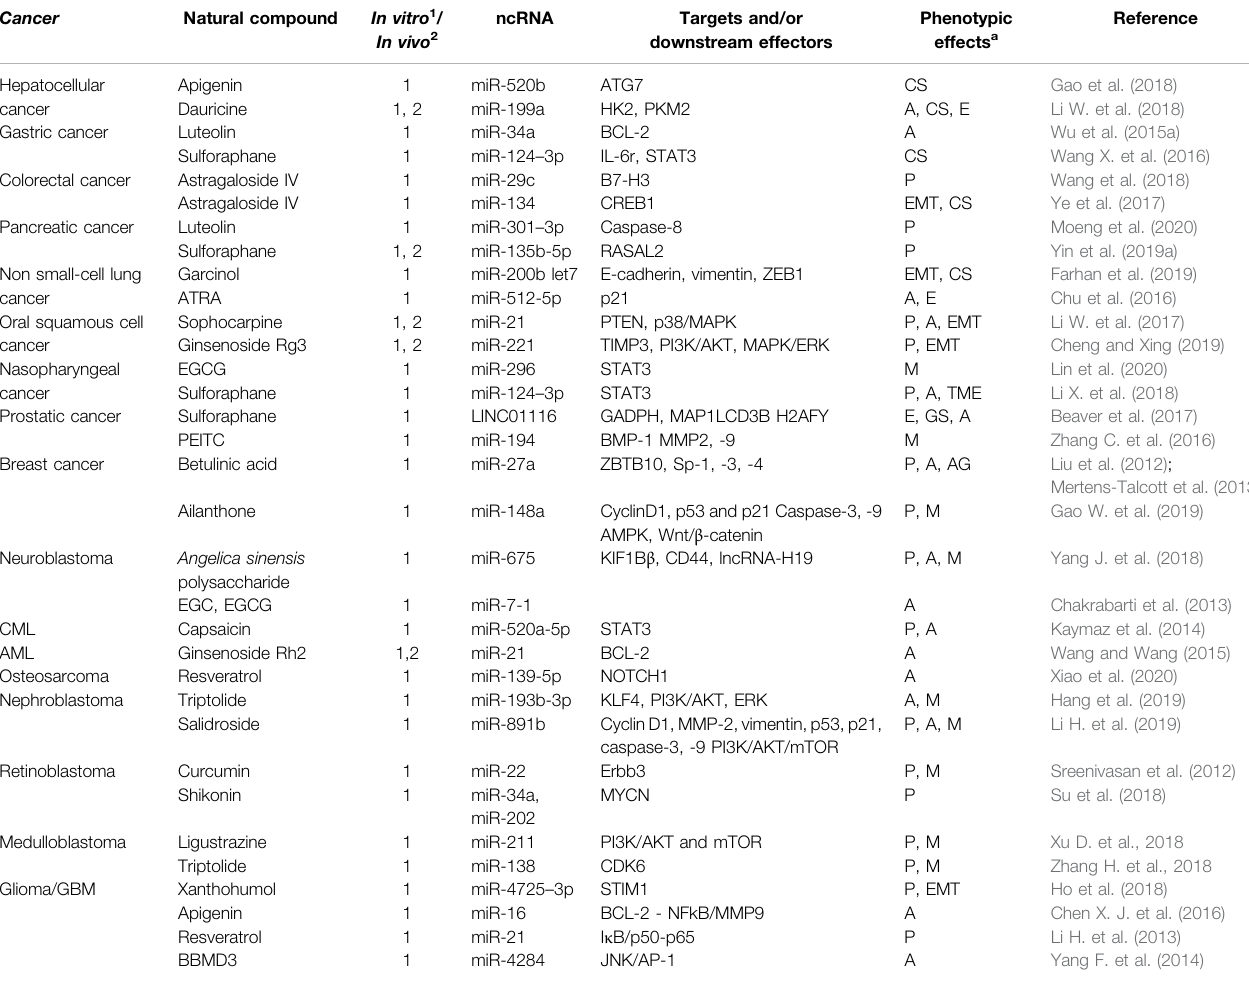
TABLE 2 | Types of cancers covered in this review and some of the most representative examples of natural compounds/derivatives acting on ncRNAs, the type of material studied on (cell lines, i.e., in vitro or mouse models i.e., in vivo ), the mechanistic pathway downstream of the ncRNA and the phenotypic effect achieved. Cancer Natural